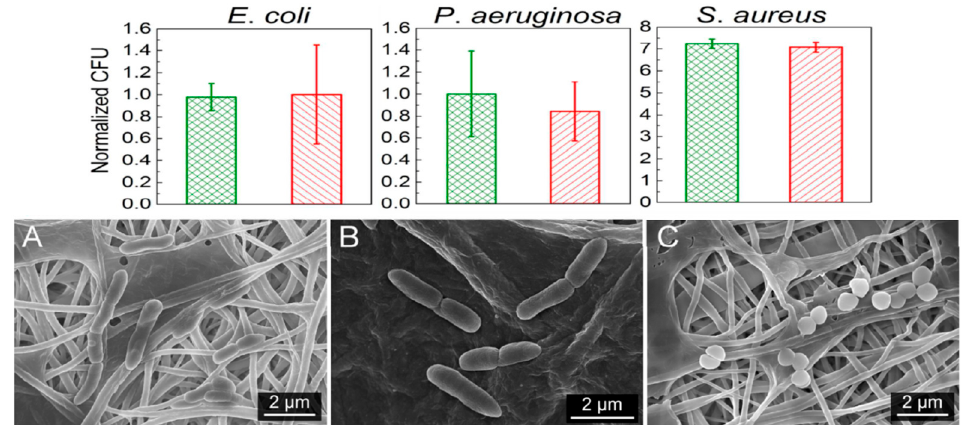
( Top Row ) Number of attached live cells on PLGA-chitosan (green column) and PLGA-chitosan / GO (red column) mats upon exposure to E. coli , P. aeruginosa , and S. aureus bacteria. ( Bottom Row ) images of E. coli ( A ), P. aeruginosa ( B ), and S. aureus ( C ) attached on the PLGA-CS / GO samples. Reproduced with permission from [173], Copyright American Chemical Society, 2015.